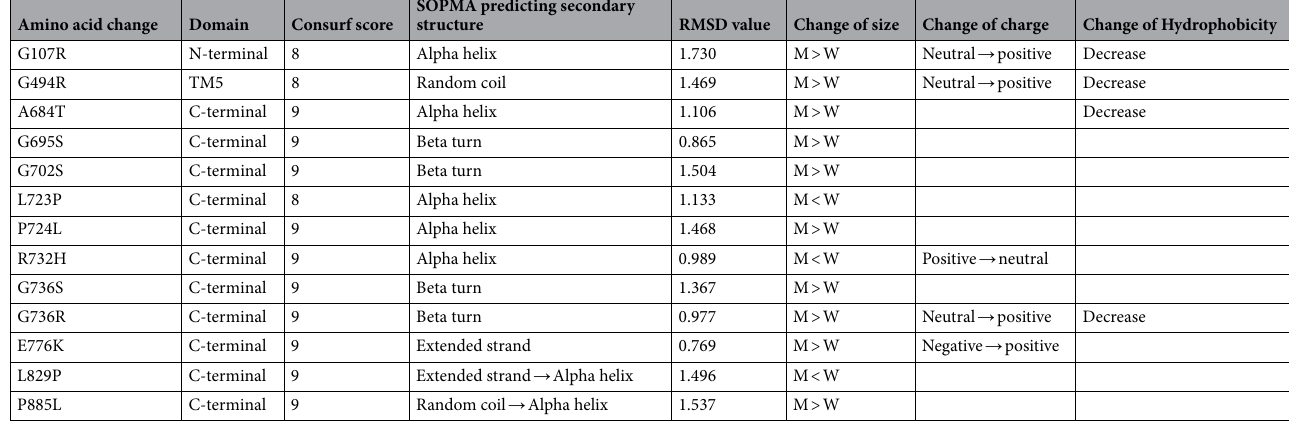
Table 3. Evolutionary conservativeness analyses and protein prediction of WFS1 high-risk pathogenic nsSNPs. TM transmembrane, W wild type, M mutant